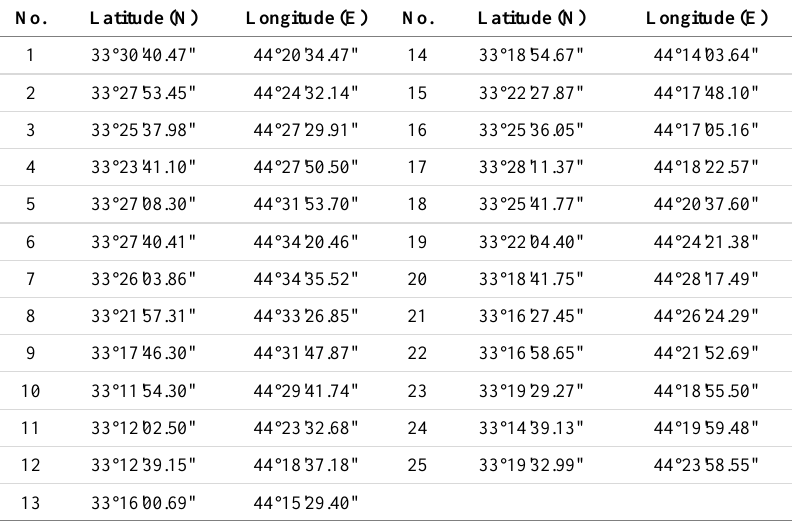
Table 2. Collected Fieldwork